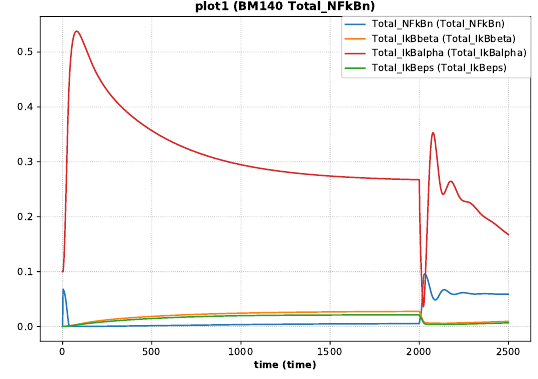
Figure A.19: The simulation result gained from the simulation description given in Listing A.11. Simulation with SED-ML web tools [2].